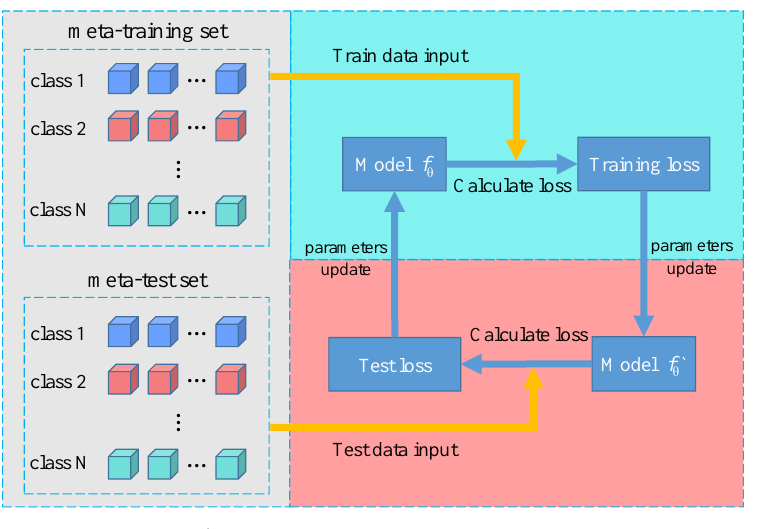
Figure 3. Diagram of MAML.